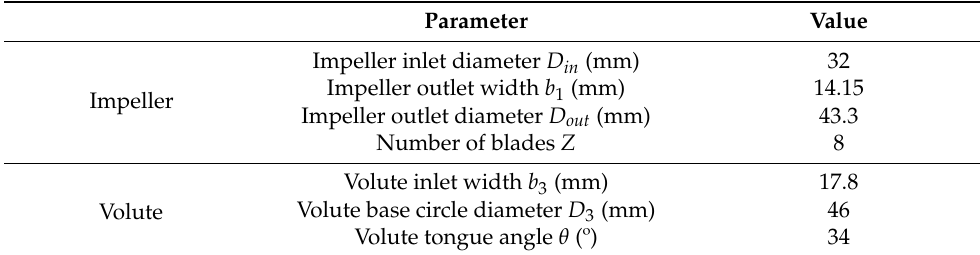
Table 1. Essential parameters of the dishwasher